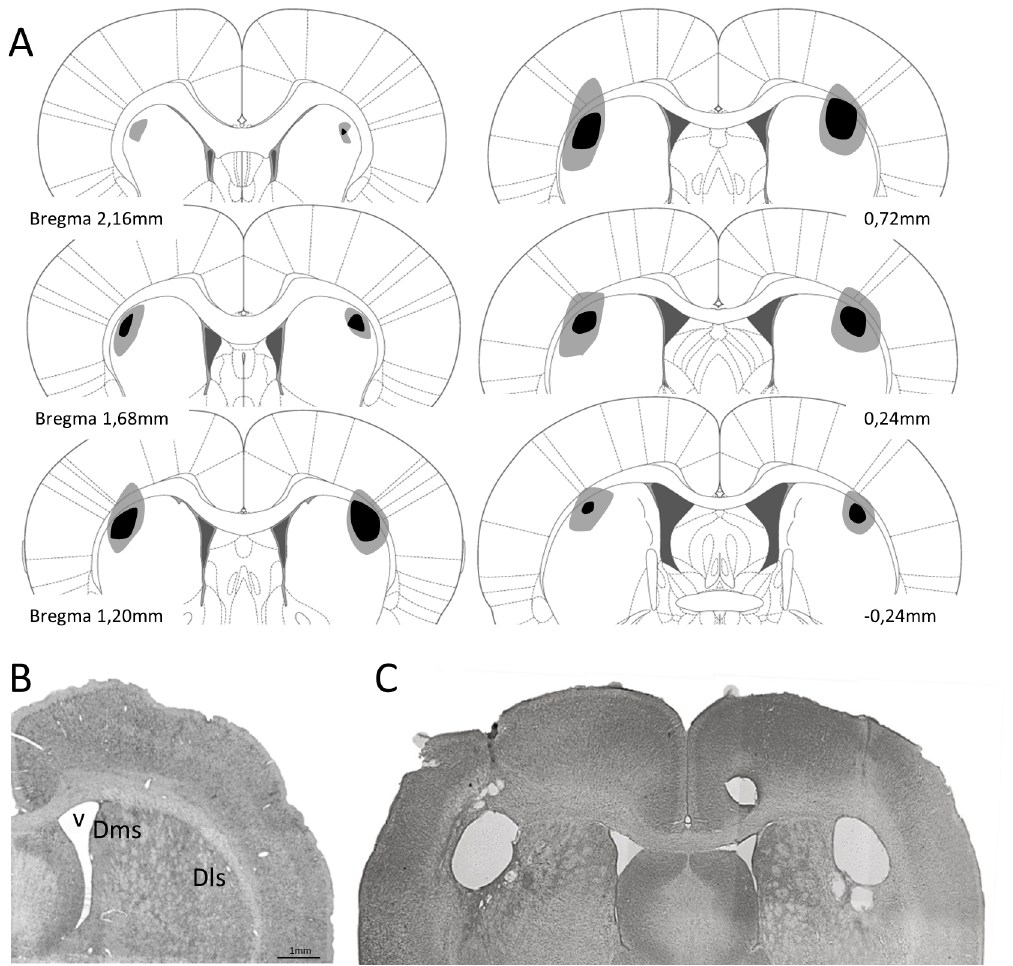
Fig 1. A. Reconstruction of the dls lesions displayedon standardcoronal sections from the atlas of Paxinos and Watson [35]. The largest lesion is shown in pale shadingand the smallest in dark shading. B . Photomicrograph showinga no lesionedcoronal brain section and ( C ) a coronalsection after excitotoxic lesionof dls. Dls: dorso-lateral striatum; Dms: dorso-medial striatum; v: lateral ventricle.